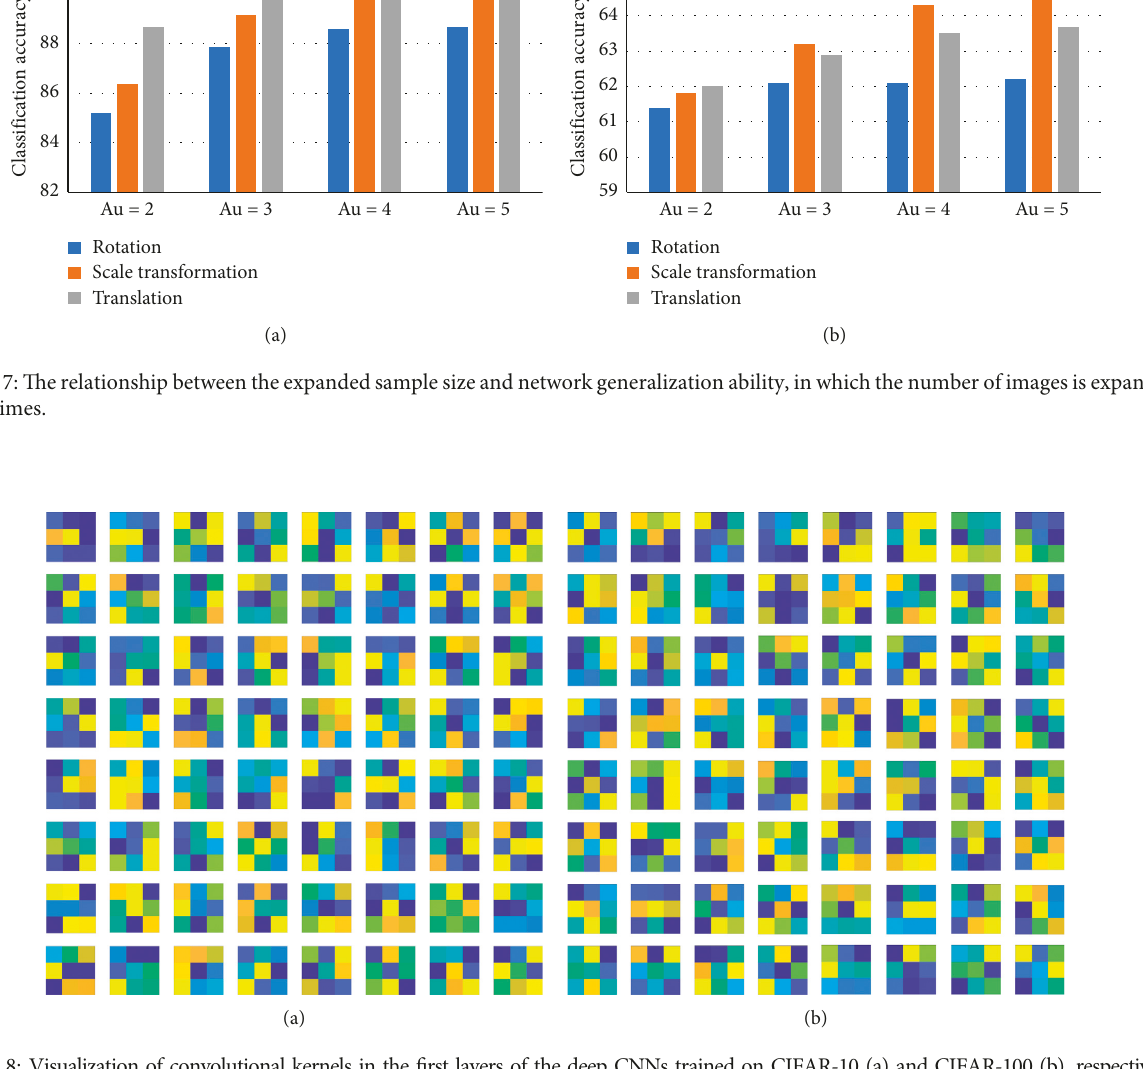
Figure 8: Visualization of convolutional kernels in the first layers of the deep CNNs trained on CIFAR-10 (a) and CIFAR-100 (b), respectively.